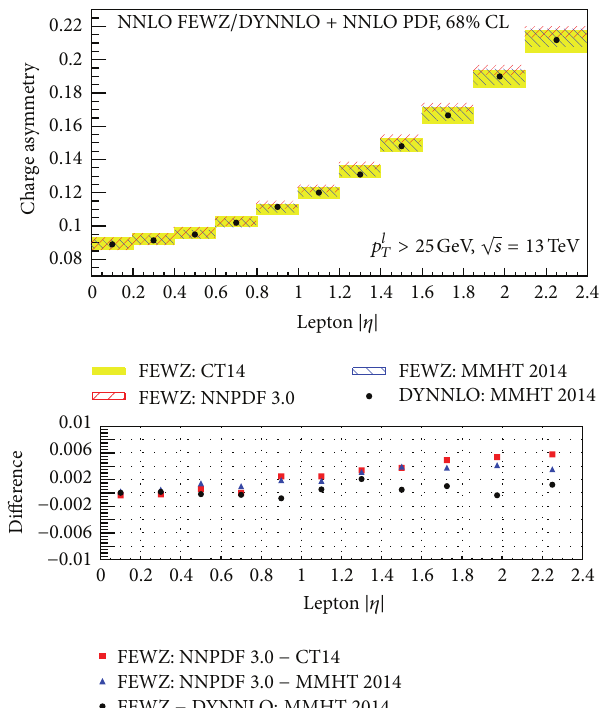
Figure 8: Predicted asymmetry values as a function of muon pseudorapidity with NNLO QCD corrections. The predictions are calculated using the FEWZ 3.1 MC tool interfaced with different PDF sets (colorful bands) and they are compared with DYNNLO predictions (black